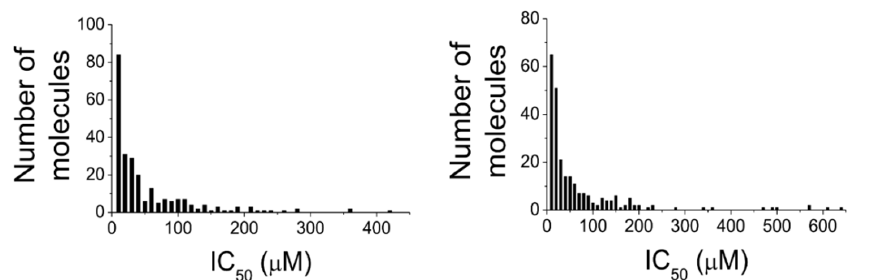
Table 13. Distribution frequency of IC 50 values for PTP1B and α -glucosidase.